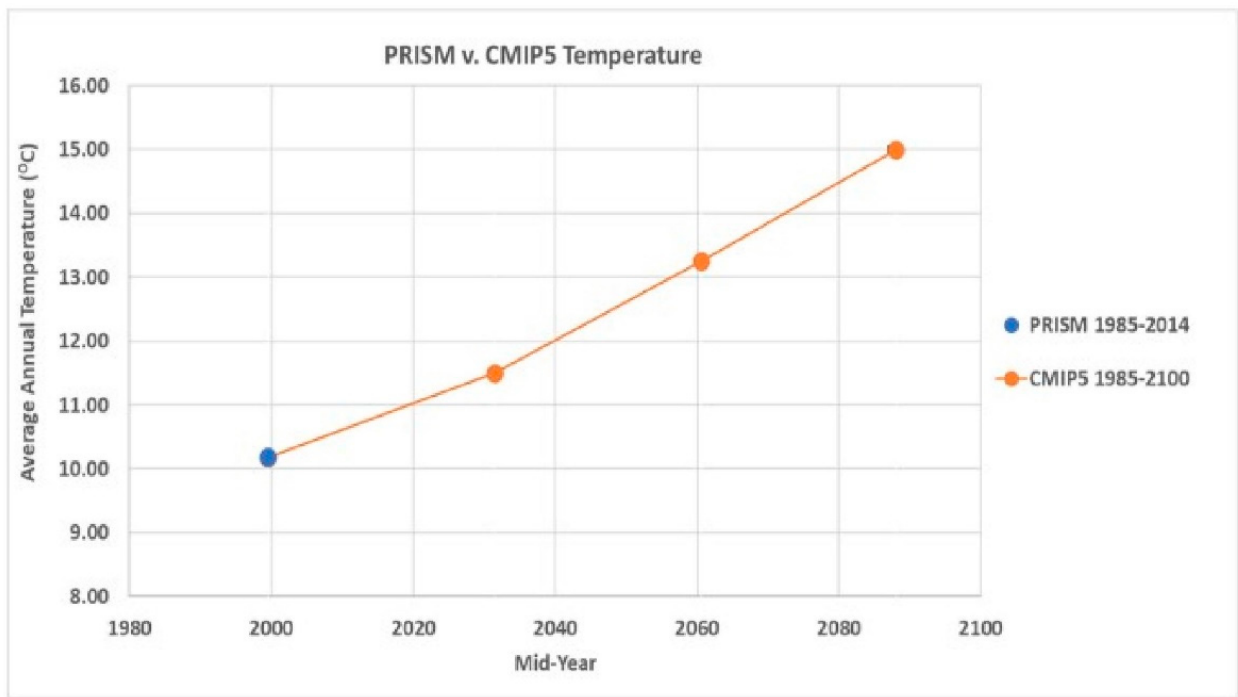
Figure 3. PRISM vs. Average of 20 CMIP5 GCMs temperature.